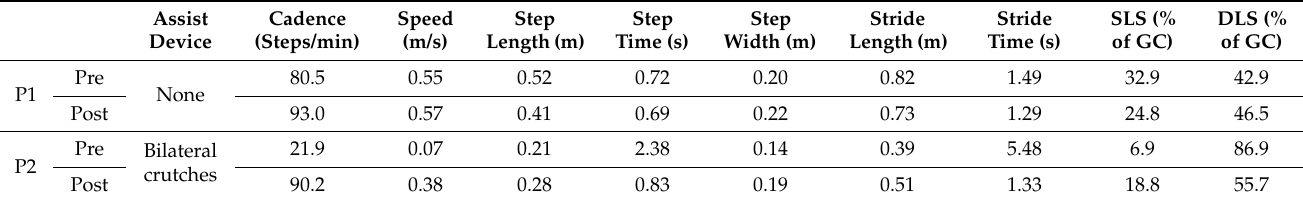
Table 3. Gait spatial and temporal parameters in children with cerebral palsy (CP) before and after robot-assisted gait training.